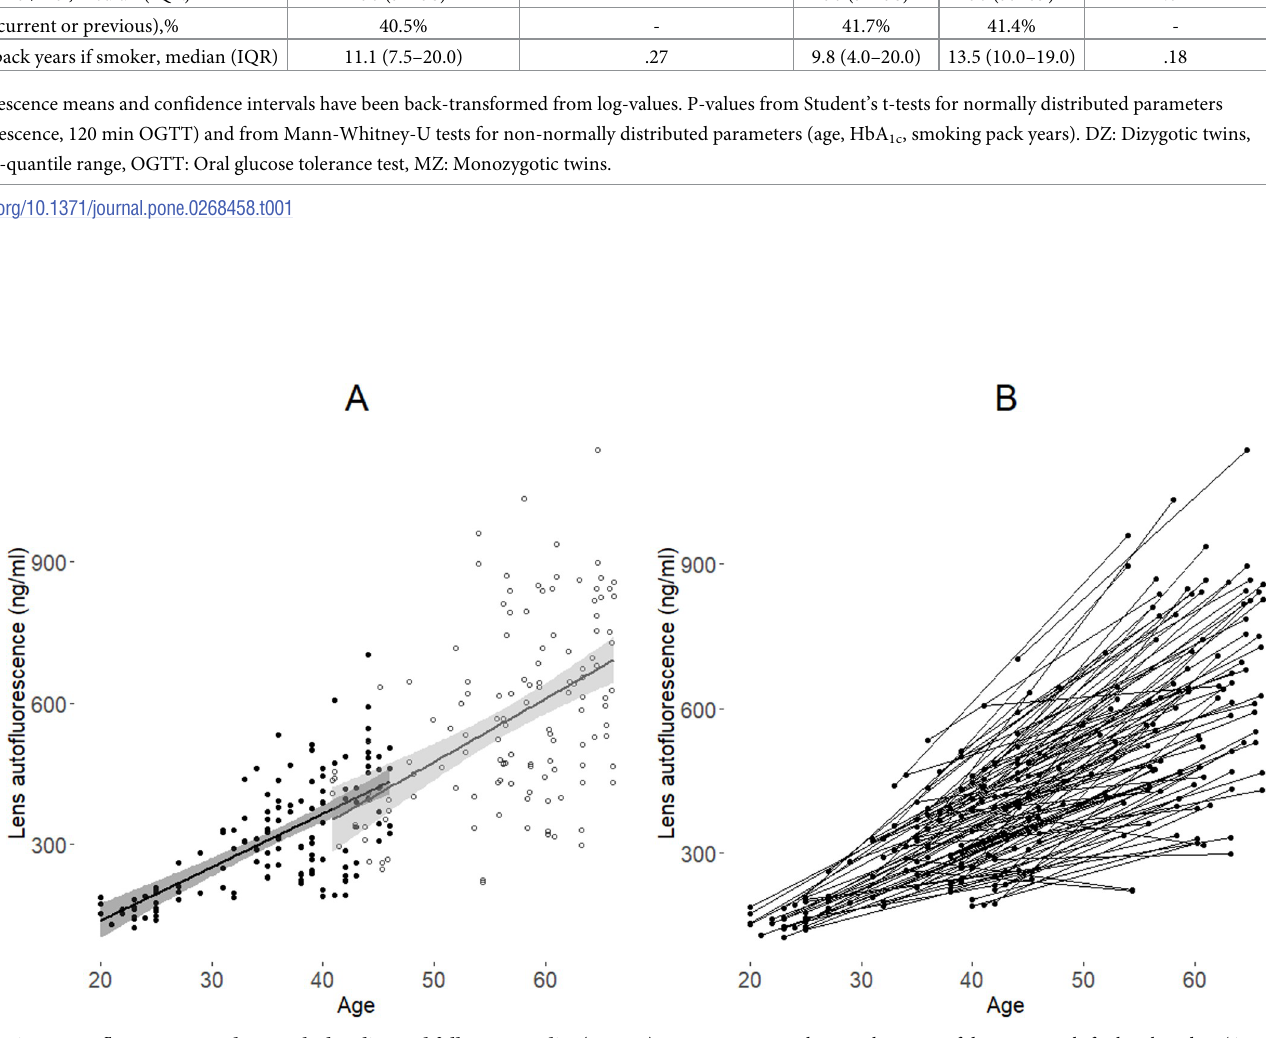
Fig 2. Lens fluorescence and age at the baseline and follow-up studies (n = 131). Linear regression lines with 95% confidence intervals for baseline data (A, black dots, black regression line) and follow-up data (A, hollow circles, grey regression line) and paired-measurements plot